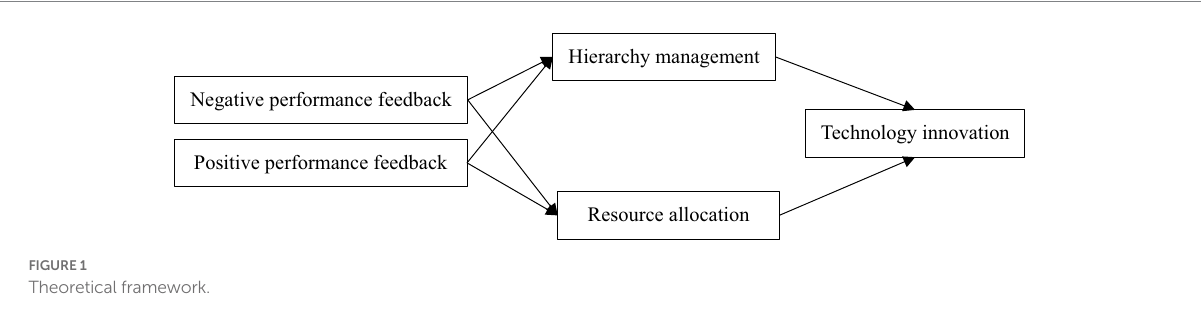
FIGURE 1 Theoretical